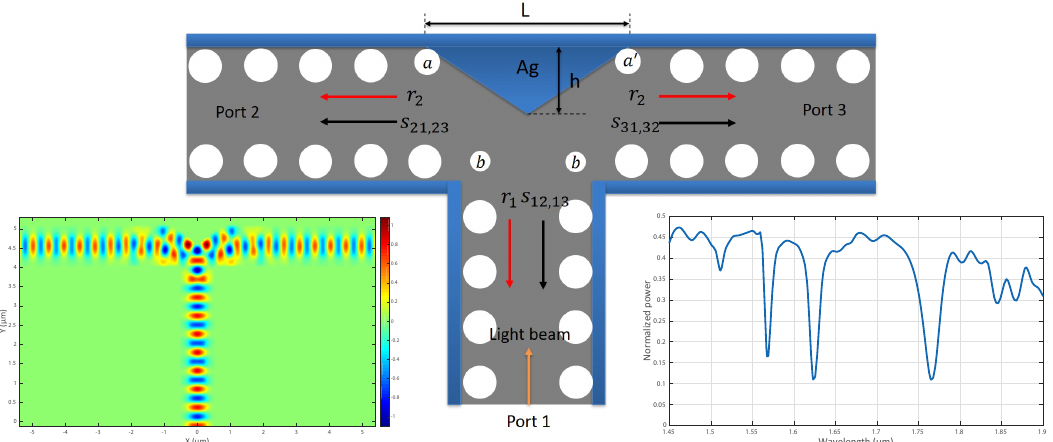
Figure 11. The structure of a T-type splitter with its beam propagation in the lower left inset. The right insert of Figure 11 is the spectrum of the T